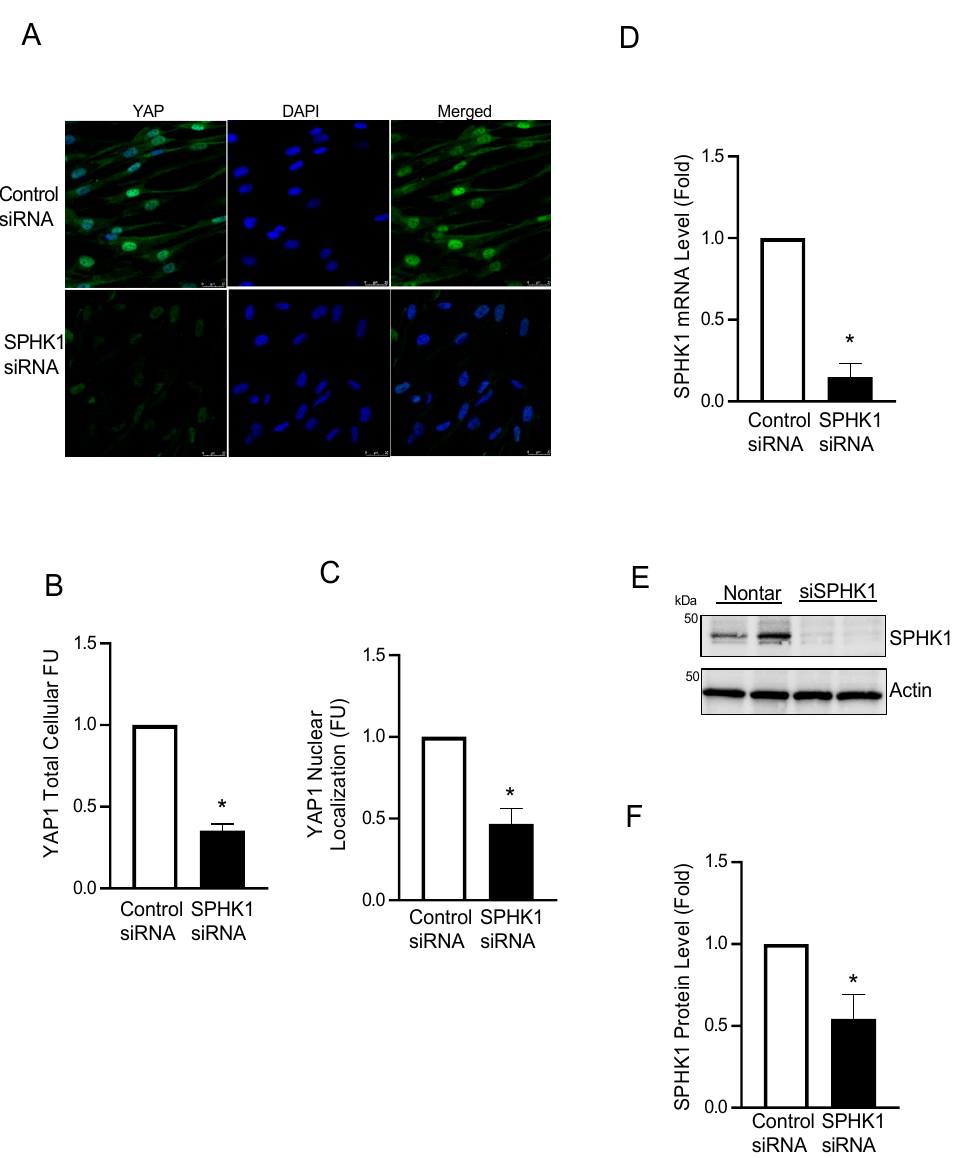
Figure 7. Silencing SPHK1 via siRNA attenuates YAP1 expression and nuclear translocation. hPASMCs were treated with control or SPHK1 siRNA (30 nM) for 72 h. ( A – C ) Immunofluorescence staining data and quantification data showing decreased total cellular and nuclear YAP1 levels; ( D ) real-time PCR showing decreased SPHK1 gene expression levels. ( E , F ) Representative Western blot images and β -actin-normalized quantification of protein demonstrate that SPHK1 protein levels were significantly silenced by siRNA. n = 3. * p < 0.05 versus control siRNA. Scale bar: 25 µm.